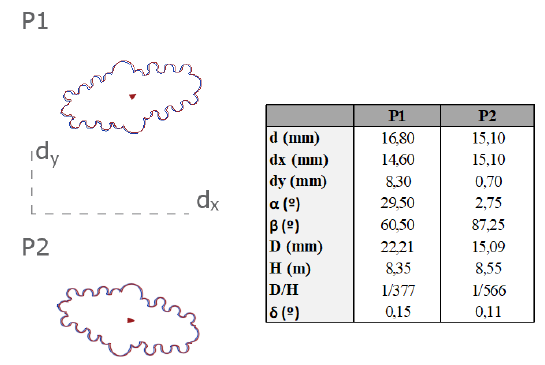
Figure 10: Out of plumbs obtained from the pillars.